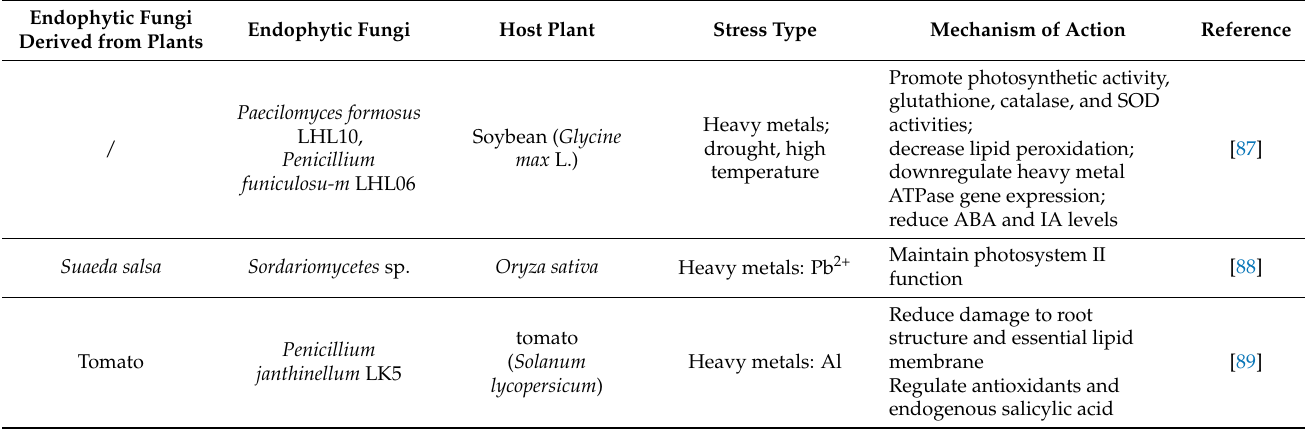
Table 1. Endophytic fungi promote plant tolerance to both biotic and abiotic